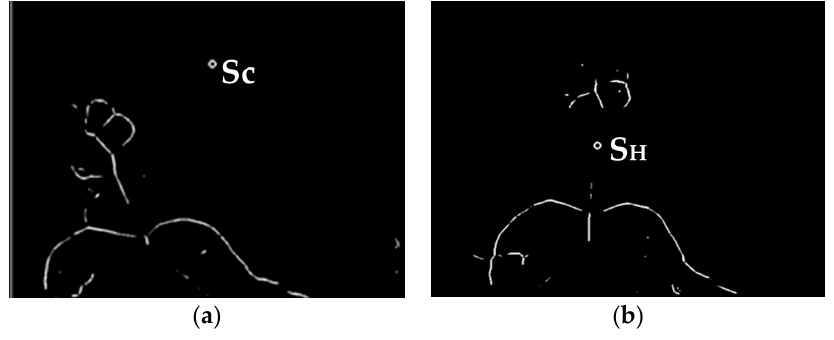
Figure 10. Establishing the skeleton point of the head: ( a ) The user approaches the preset point, which triggers detection. ( b ) The skeleton feature map combined with YCbCr elliptical skin color detection establishes the head skeleton point.